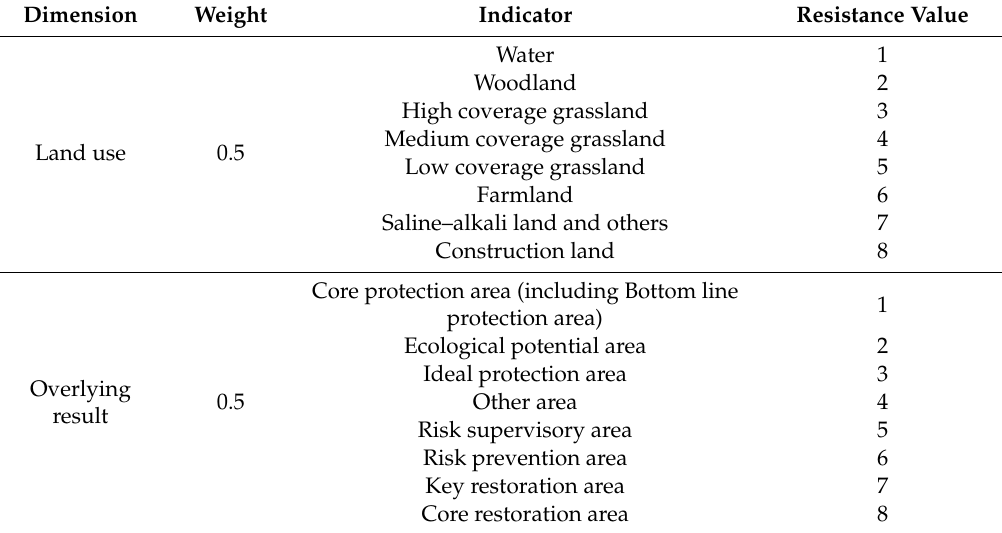
Table 6. Establishment of the resistance